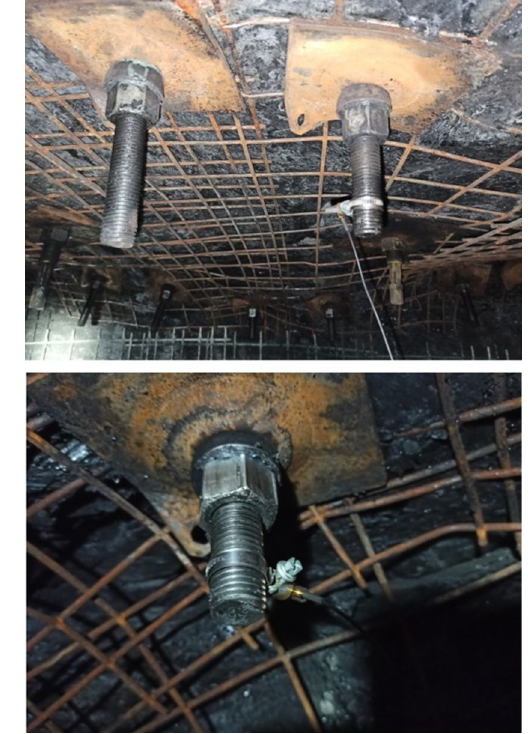
Fig. 9 The investigated rock bolts in an underground opening in a working coal mine